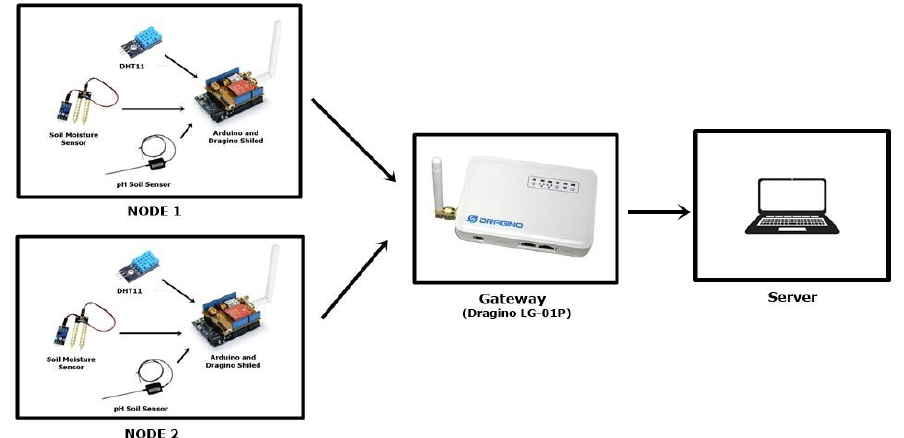
Figure 3. Client–server communication flow